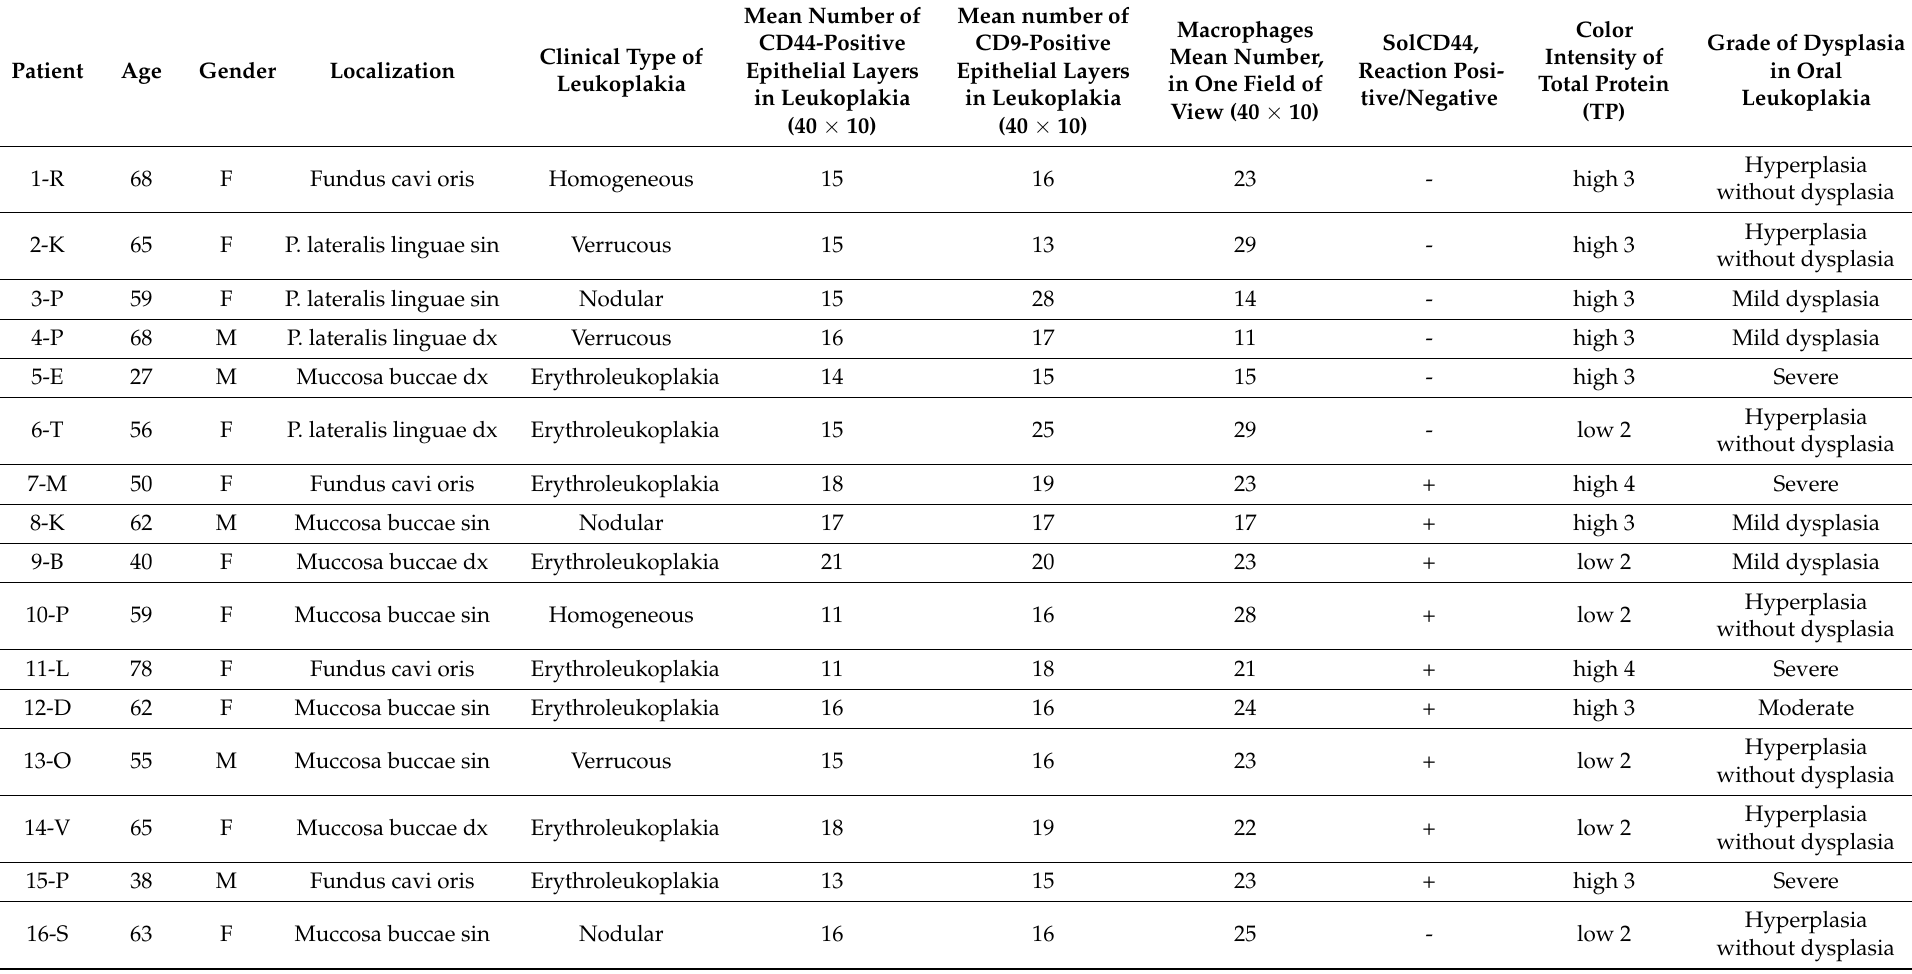
Table 1. Characteristics of the cohort by age, gender, localization, clinical type of leukoplakia, grade of dysplasia, mean number of CD44-positive epithelial layers in leukoplakia